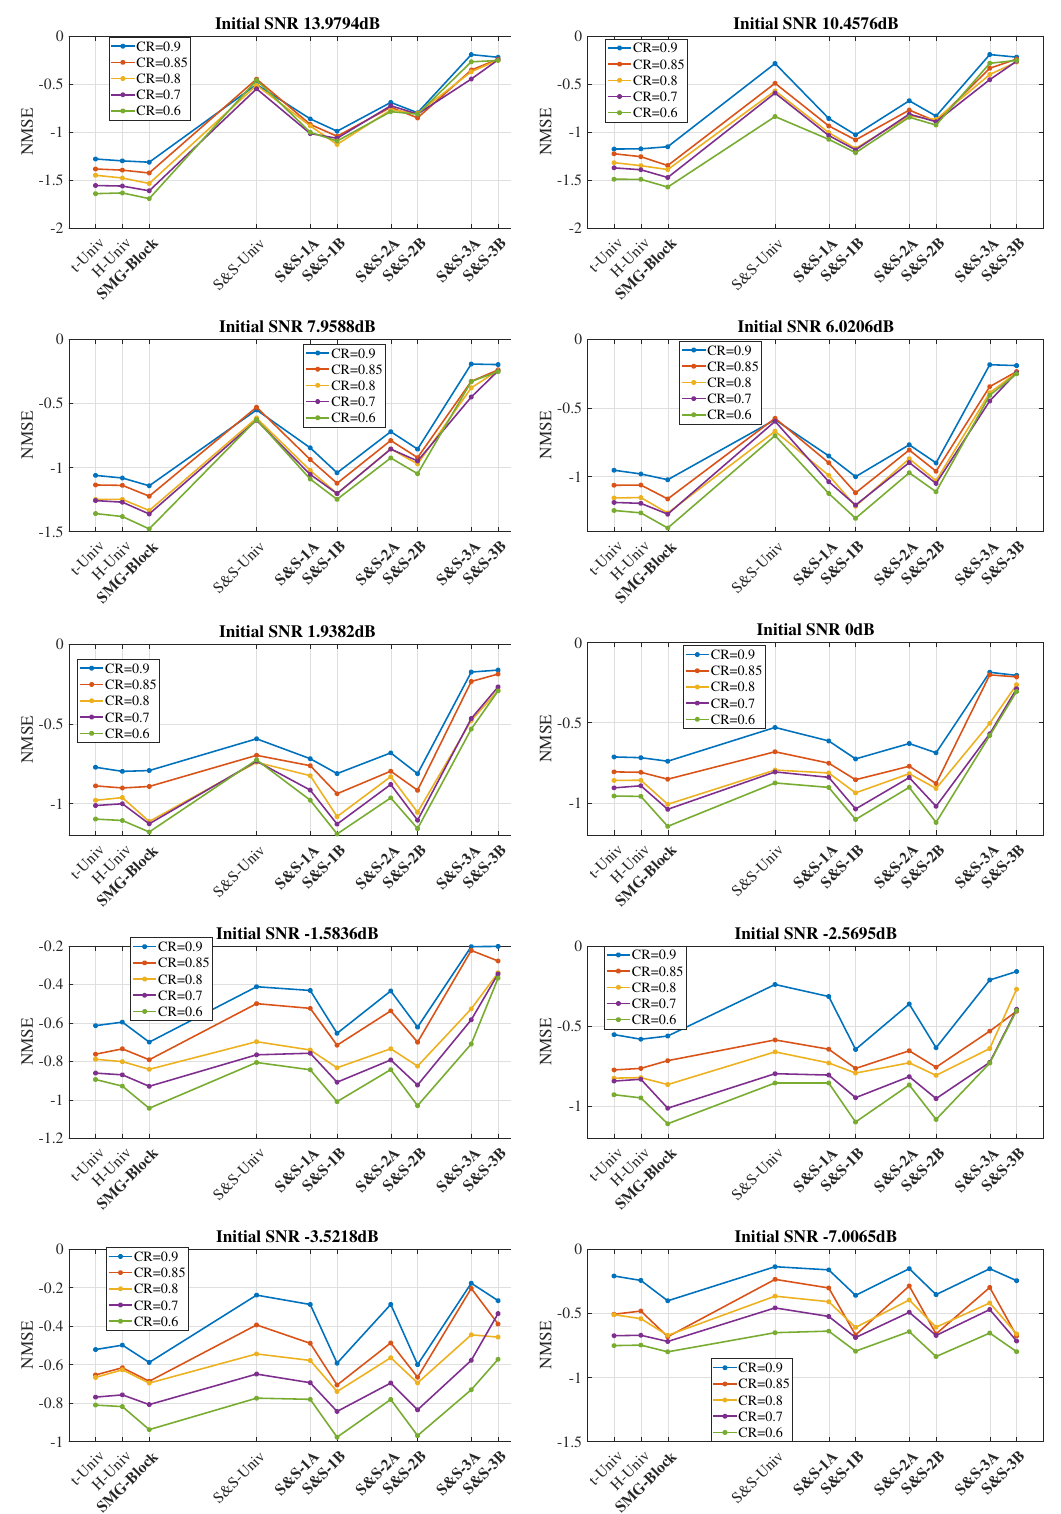
Figure 3. Normalized mean square error (NMSE) (in logarithmic scale) for different Gaussian noise levels and compres- sion